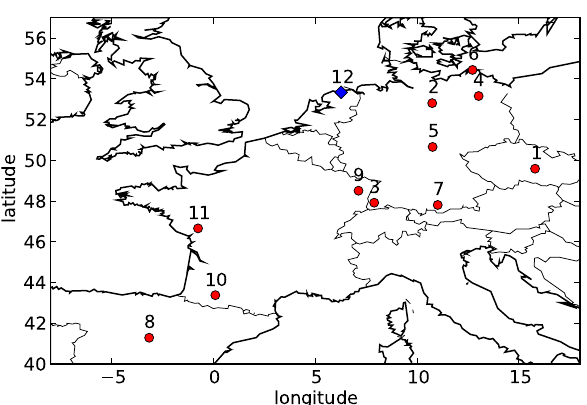
Fig. 1. The 11 monitoring stations of the EMEP network for volatile organic compounds whose observations are assimilated are indi- cated with a circle. The Kollumerwaard station in the Netherlands used for validation only is indicated by a rhombus.